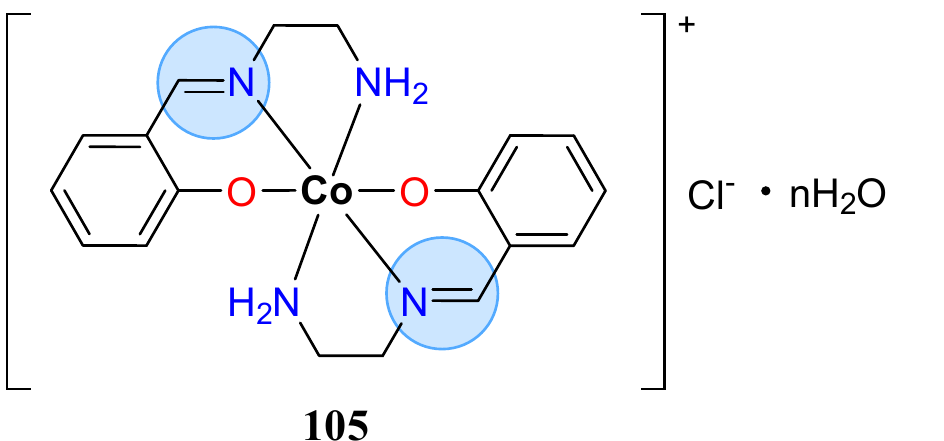
Figure 54. Co(III) complex with a tridentate SB ligand derived from salicylaldehyde and ethylenediamine tested as antimicrobial agent.